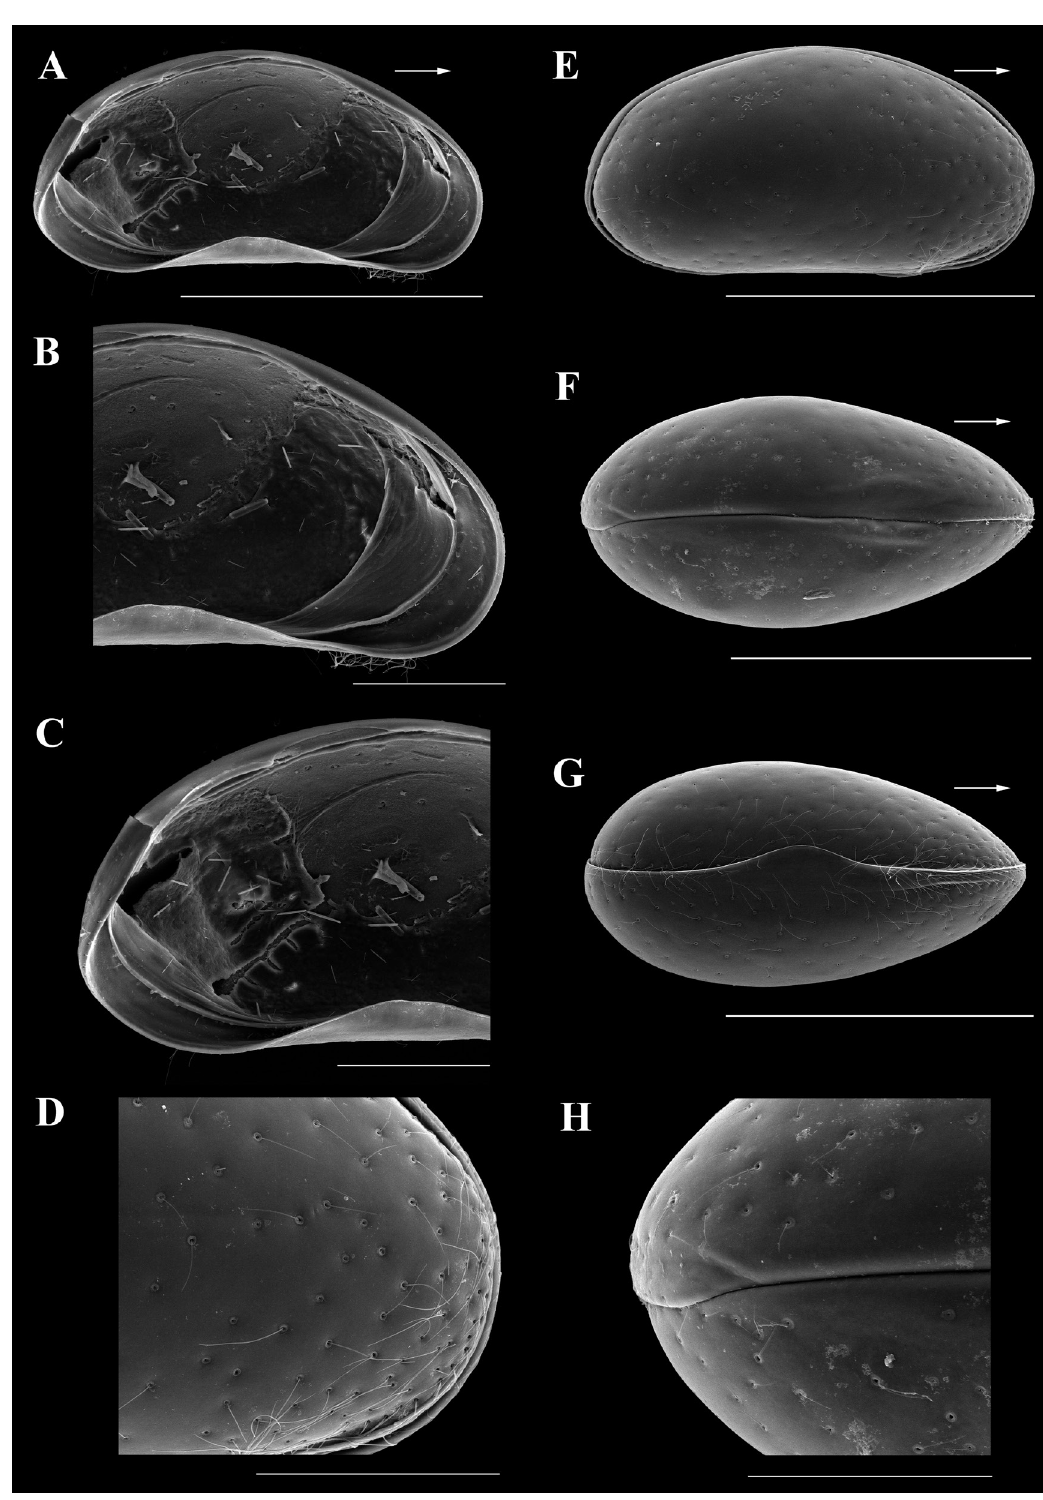
Fig. 13. Brasilodopsis amazonica gen. et sp. nov. from Amazon River floodplain, ♂. A . LVi (MZUSP 41856). B . LVi, detail of anterior part (MZUSP 41856). C . LVi, detail of posterior part (MZUSP 41856). D . CpRl, detail of Cp surface (MZUSP 41857). E . CpRl (MZUSP 41857). F . CpD (MZUSP 41858). G . CpV (MZUSP 41859). H . CpD, detail of Cp surface (MZUSP 41858). Scale bars: A, E–G = 300 µm; B–D, H = 100